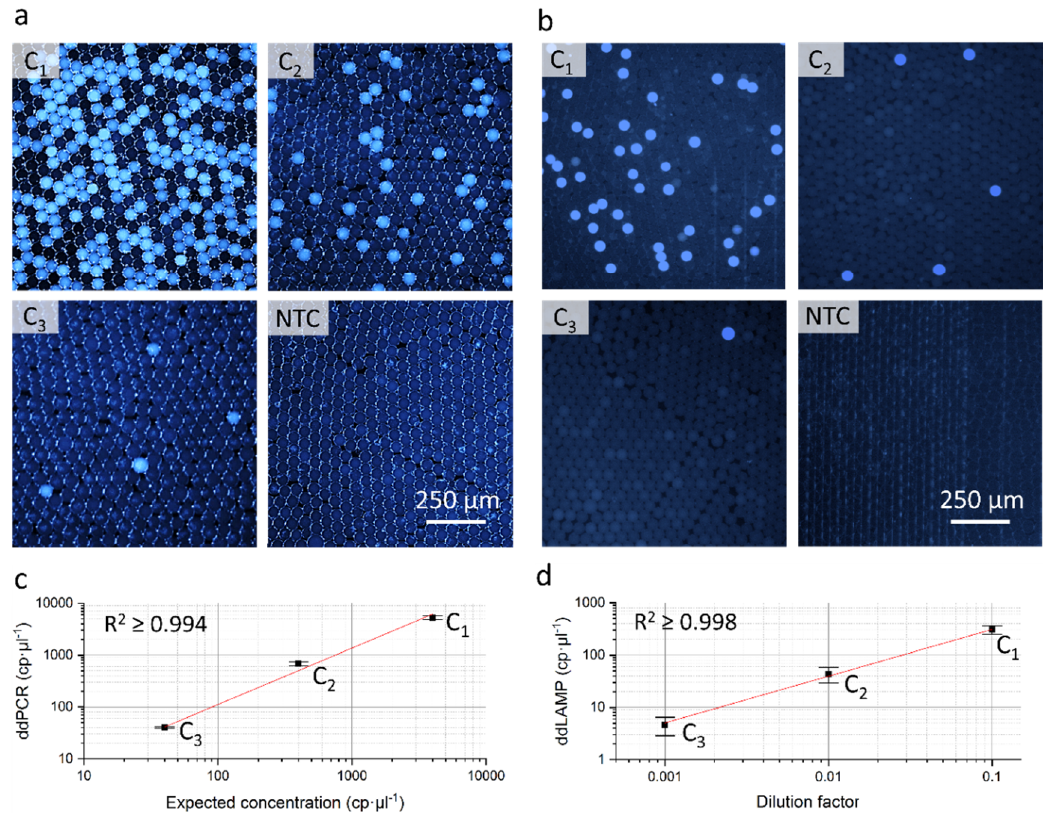
Figure 3. Results of the application examples digital droplet polymerase chain reaction (ddPCR) and digital droplet loop mediated isothermal amplification (ddLAMP). Fluorescent microscopy images of the droplet mono layers in a readout chip for the tested concentrations (C1–C3) and the non-template control (NTC) for the ddPCR ( a ) and the ddLAMP ( b ) (representative image sections cropped). Bright blue droplets represent positive droplets. Comparison of determined and expected concentrations in case of the ddPCR ( c ). Measured concentration in relation to the dilution factor of the unknown sample for the ddLAMP ( d ). Error bars represent the standard deviations of three independent runs, the red line the linear fit curve. RAW data is shown in ESI 2, S5.